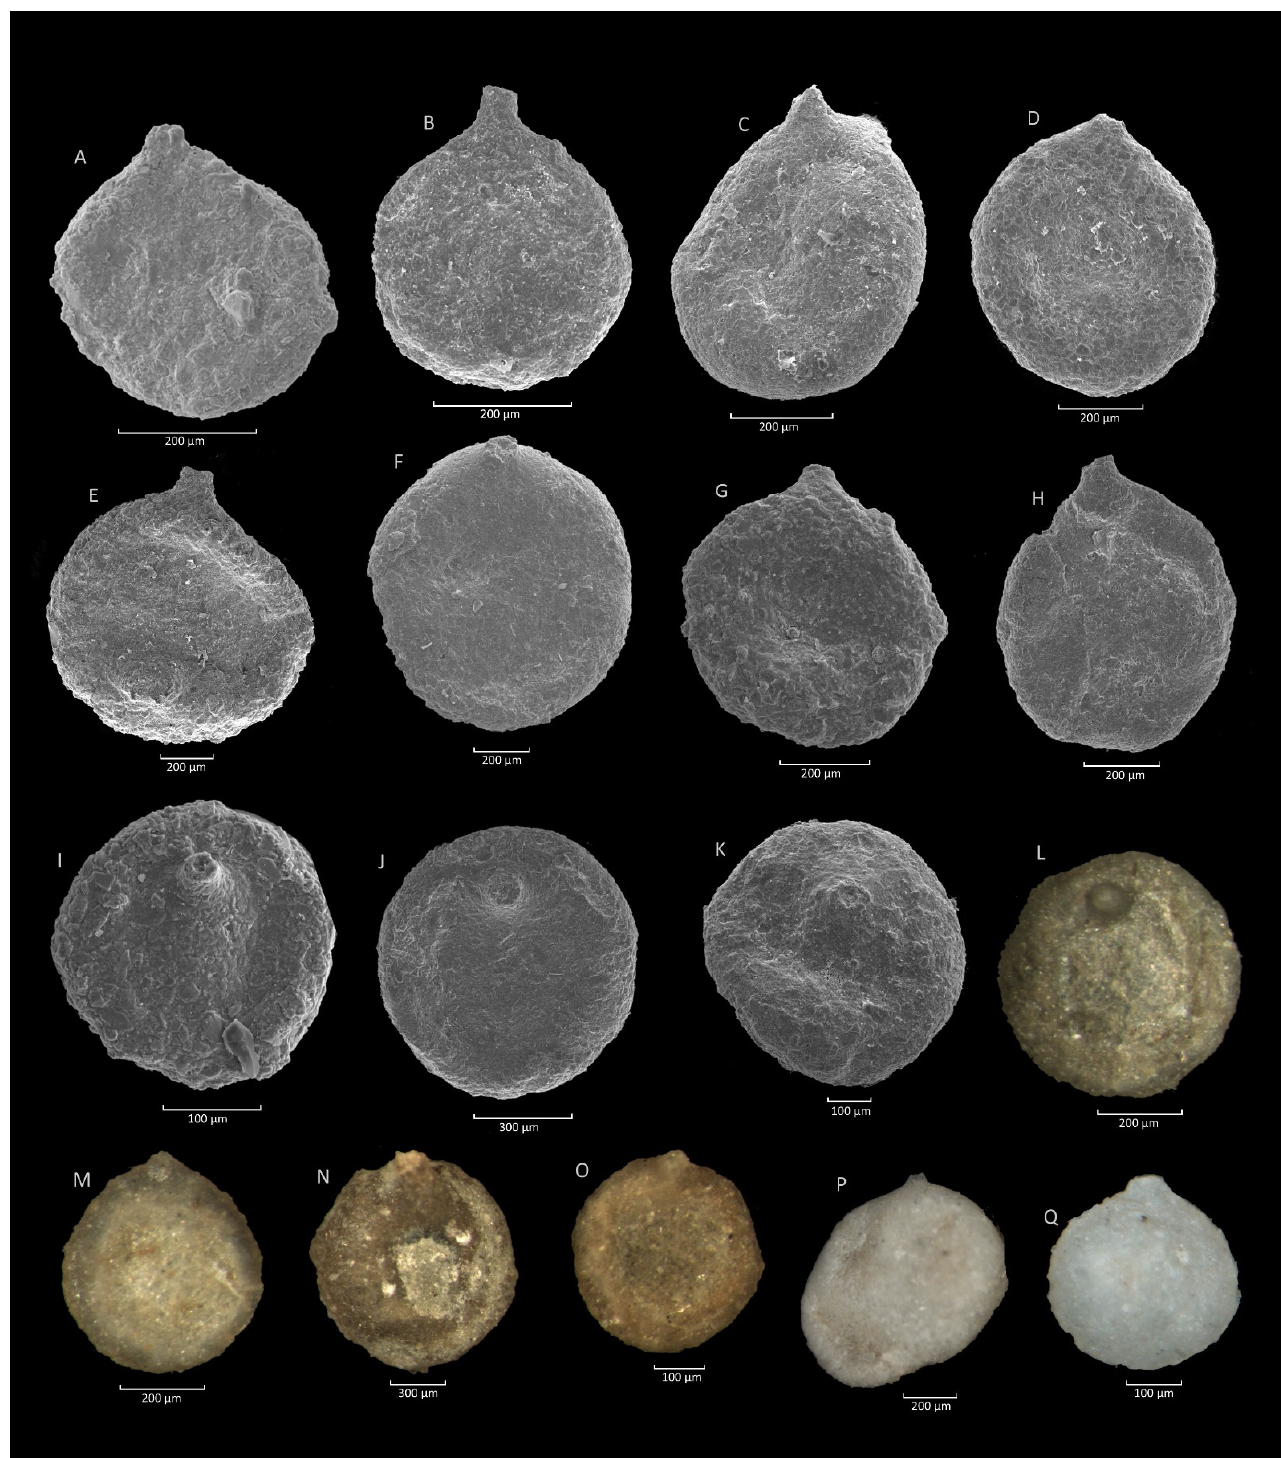
Figure 7. Placentammina placenta (Grzybowski). ( A ): Zimny Dział section; ( B ): Mutne section; ( C , D ): Rzyczki section; ( E ):